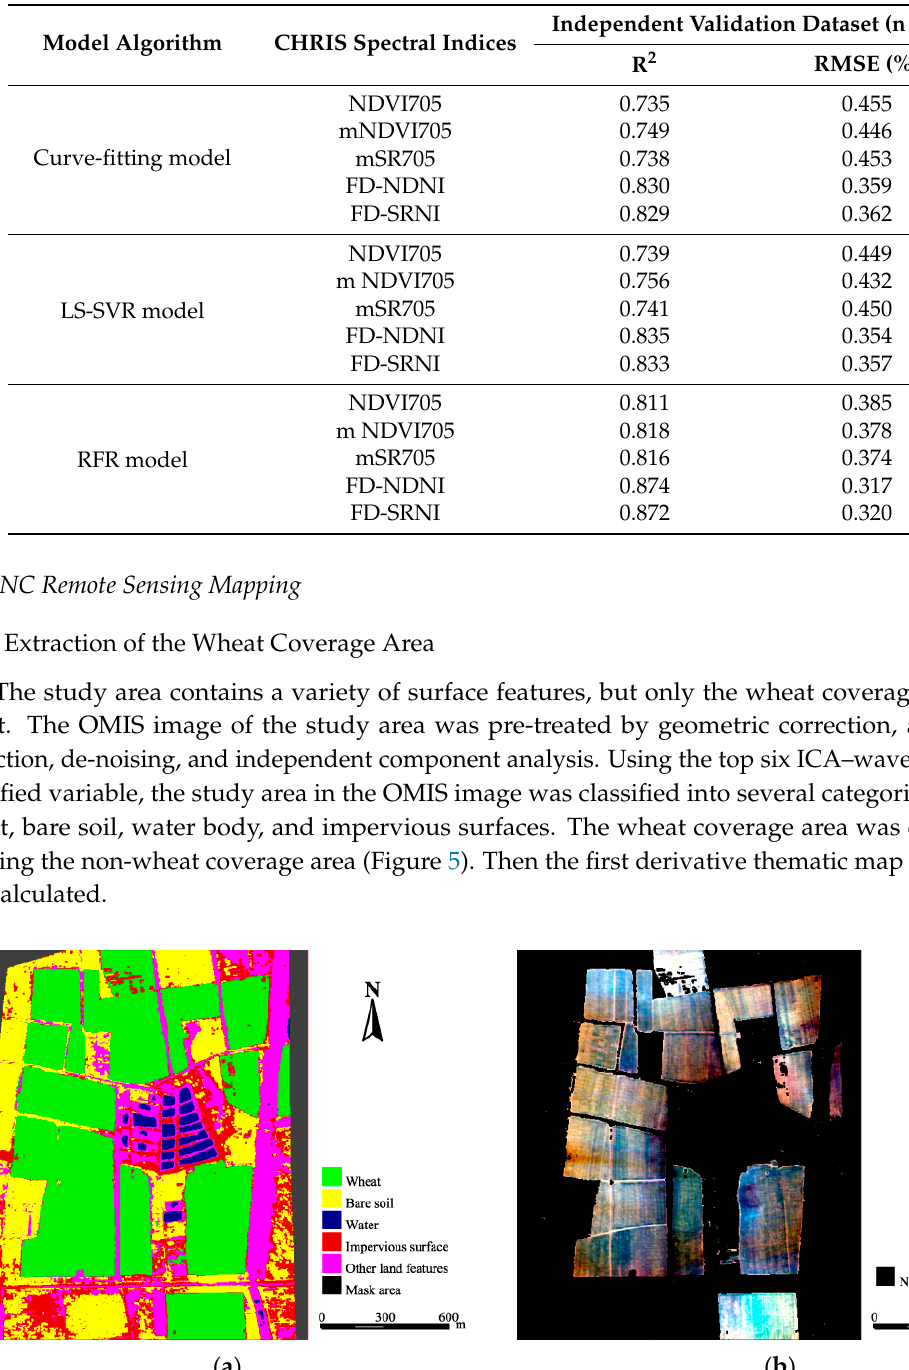
Table 4. LNC estimation results using various algorithms and spectral indices.